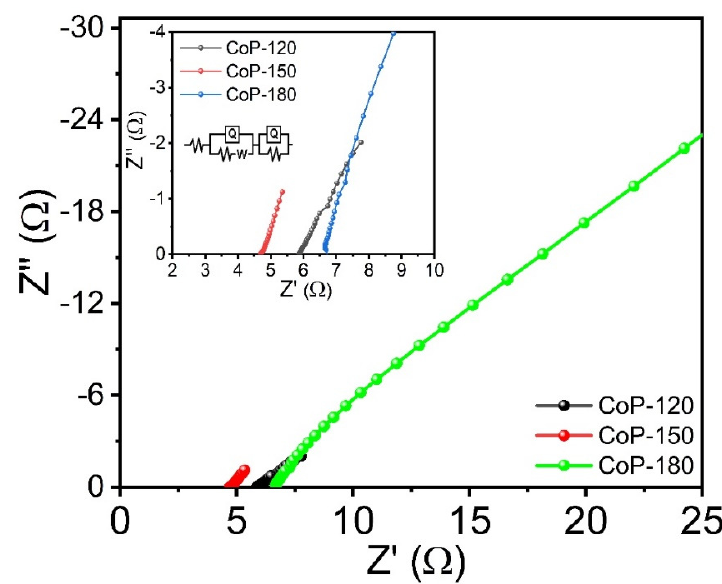
Figure 7. EIS plots of the Co 2 P 2 O 7 materials synthesized at various deposition temperatures of 120, 150, and 180 °C,